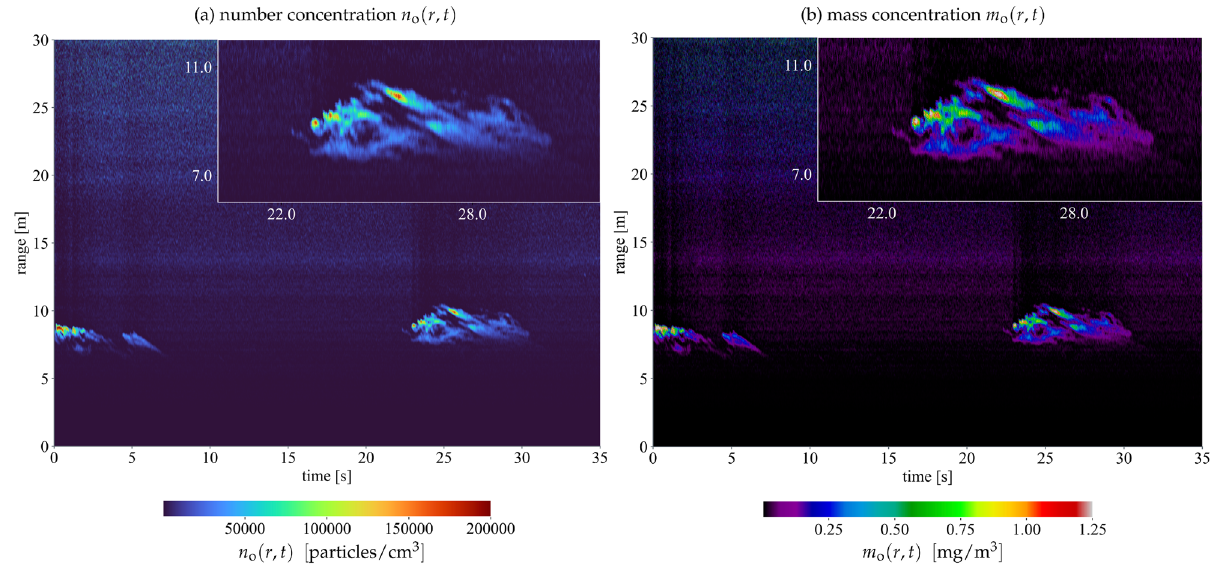
Figure 3. Range and time-resolved number n o ( r , t ) and mass m o ( r , t ) concentration profiles from the PSR-EBL technique of BC aerosols emitted by a small-scale Jet A-1 pool-fire. To highlight the resolution obtained, the inset images show a magnified view of the plume occurring between 20-30